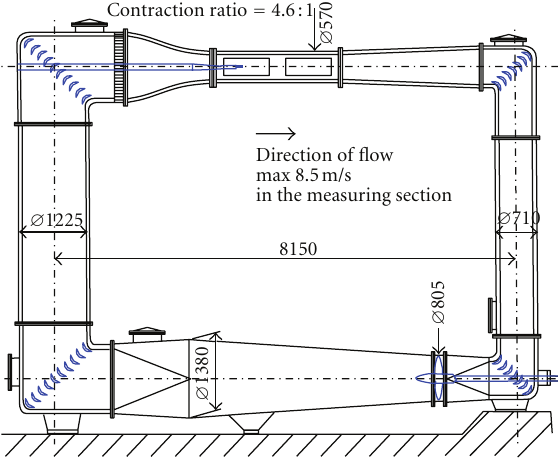
Figure 11: University of Genoa Cavitation